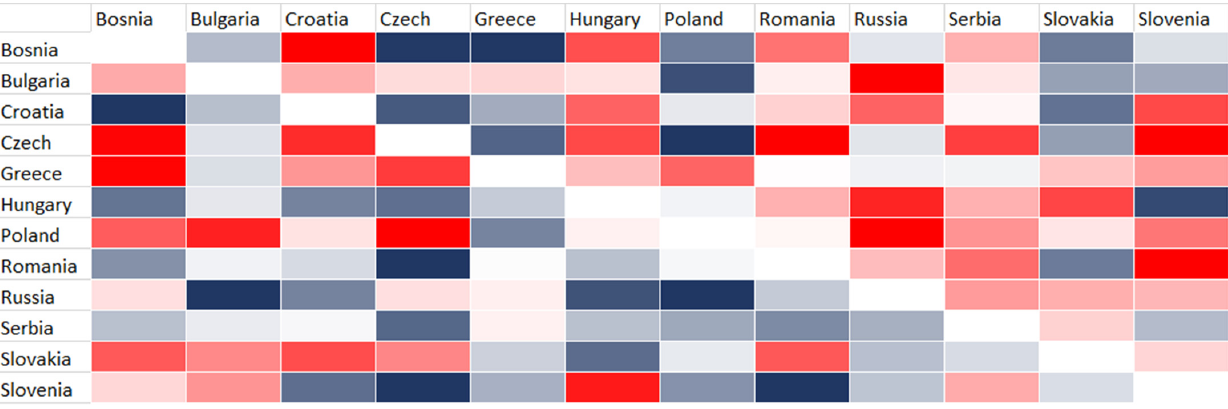
Figure 1. Heatmap of the mean transfer entropy between pairs of stock market indices. Lighter red corresponds to lower mean transfer entropy values and darker red to higher levels. The figure is read as the market in line influencing the market in the column (considering the transfer entropy levels).